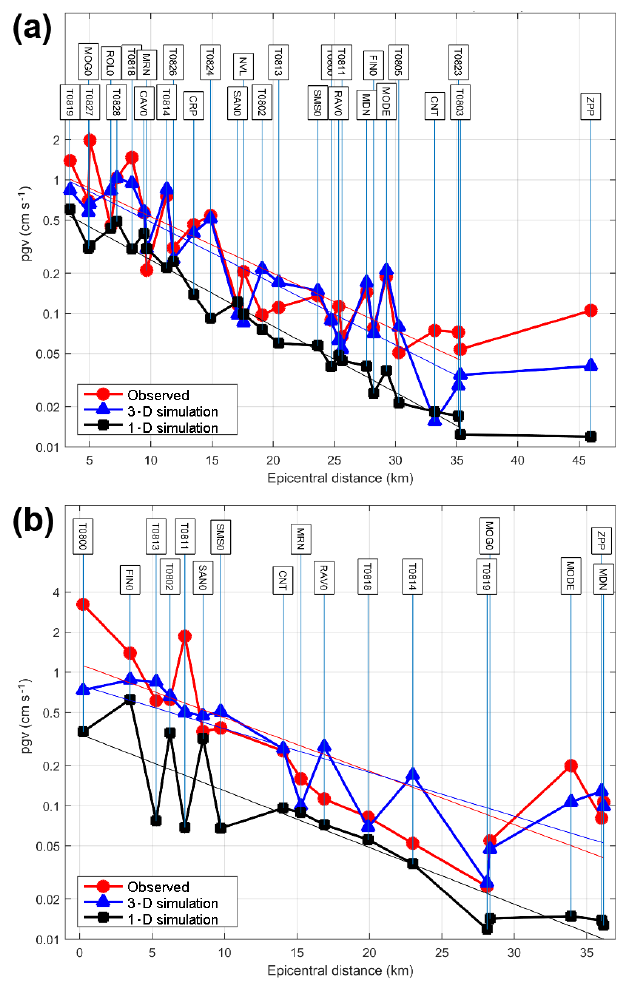
Figure 8. Observed and numerically simulated PGV (peak value of the two horizontal components) at the considered stations, plotted in function of the epicentral distance. (a) The 12 June 2012 M W 4.1 event. (b) The 23 May M W 4.0 event. The ordinate scale is loga-